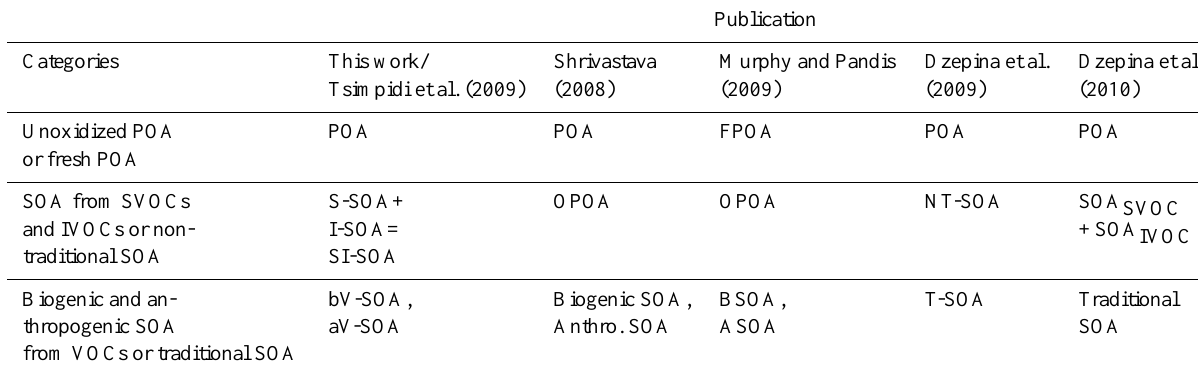
Table 1. Definitions and abbreviations used for classes of OA.